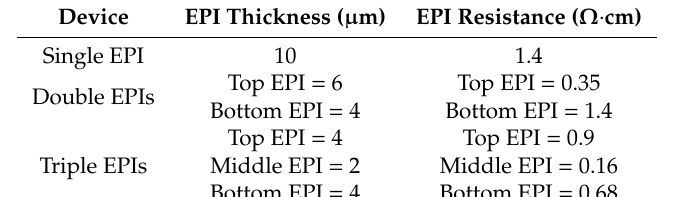
1:2. Figure 4b presents the simulated V BR and R on,sp with di ff erent EPI-thickness designs. Table 2. The parameters that were used for the single-, double-, and triple-EPI structure simulation.